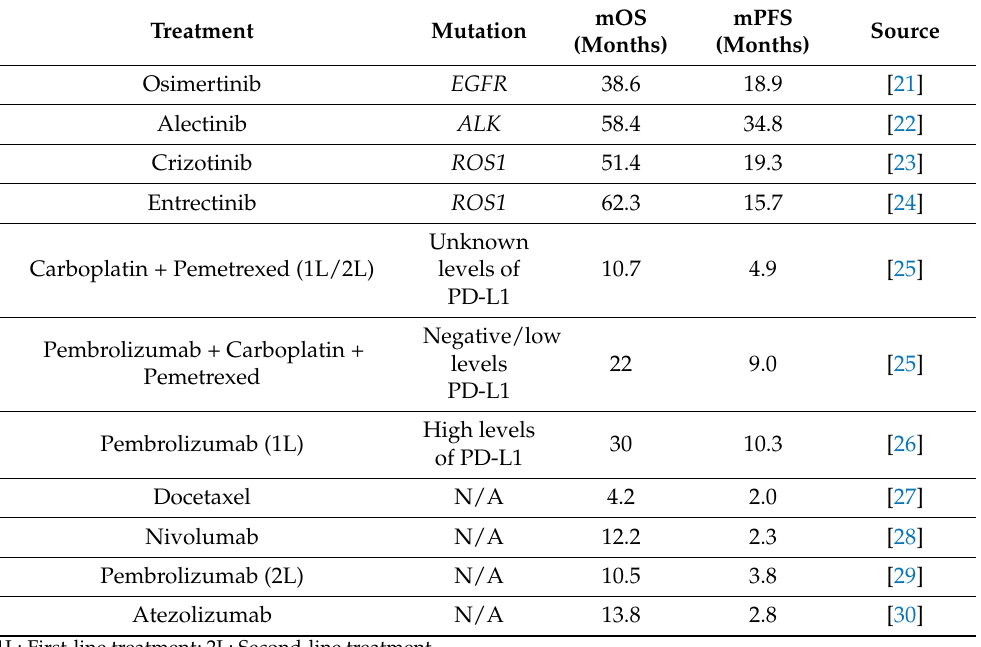
Table 4. Health outcomes data.